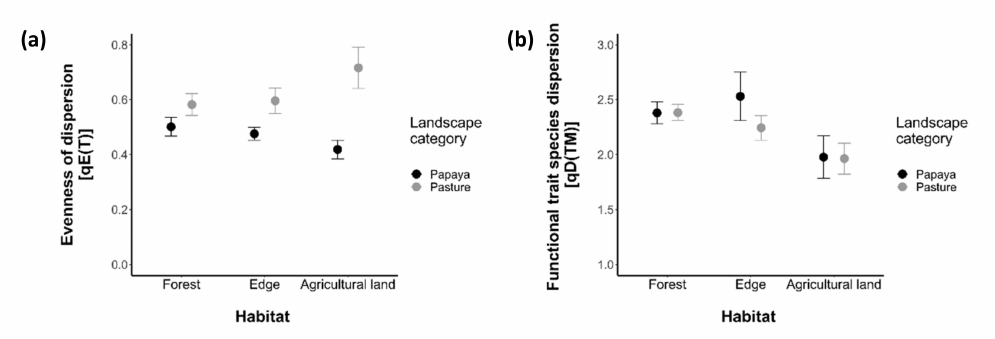
Figure 8. Comparison between site categories and vegetation types for: ( a ) evenness of dispersion [ 1 E(T)], ( b ) functional trait dispersion [ 1 D(TM)]. “ q ” represents the order of diversity metric that determines the weighting of proportional abundances; in the case of this study q equals 1 in the metric symbol. Dots represent the mean values pooling together the data for the vegetation types at all the study sites per category. Lines represent standard error bars (mean ±